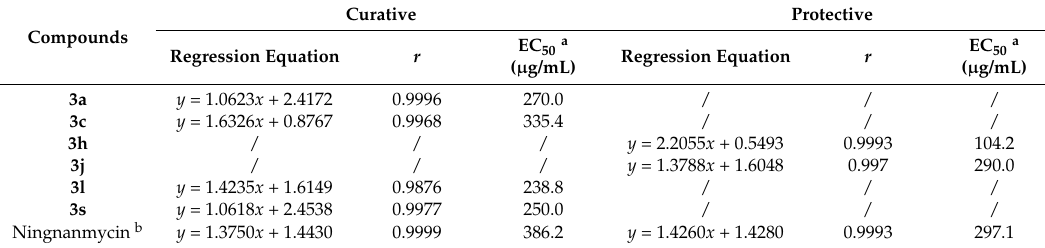
Table 4. EC 50 values of some compounds against TMV.